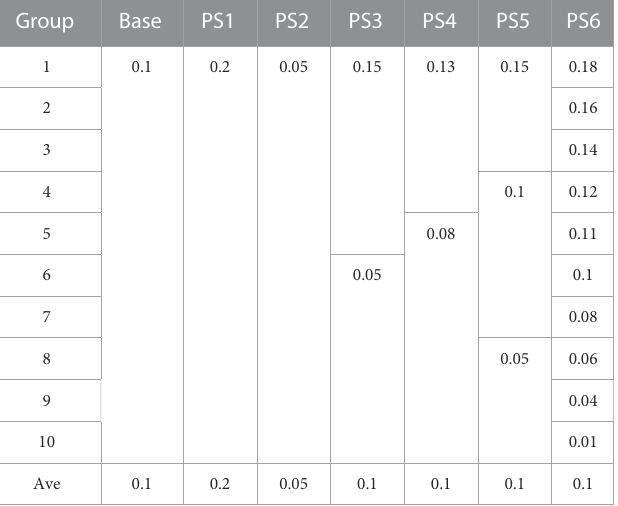
TABLE 2 Group price